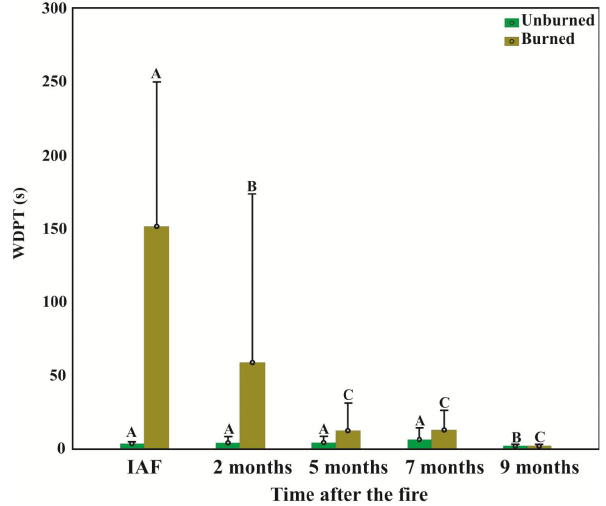
Fig. 3. Evolution of SWR (composite sample) in the unburned and burned plots in the post-fire sampling dates (bars represent ±Standard Deviation). Different letters indicate significant differences ( p< 0.05) among time.